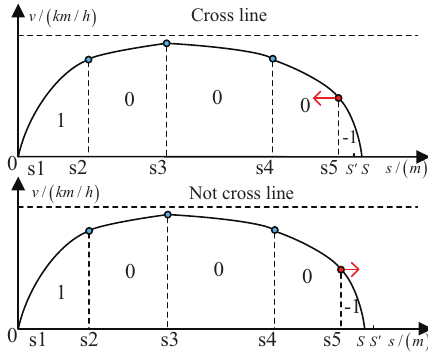
Figure 9. The penalty term Pe 2 of stopping error is not